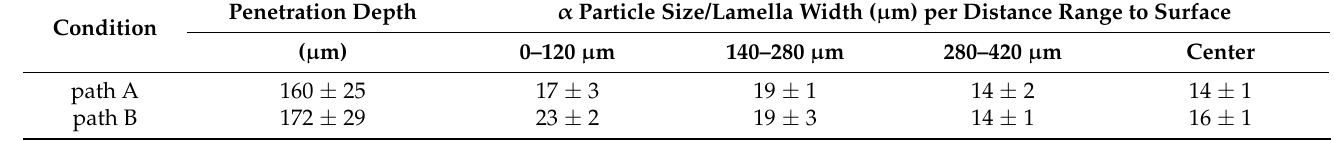
Table 6. Metallographic data of the microstructure after solution treatment and